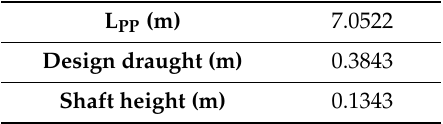
Table 1. Principal parameters of YUPENG model.